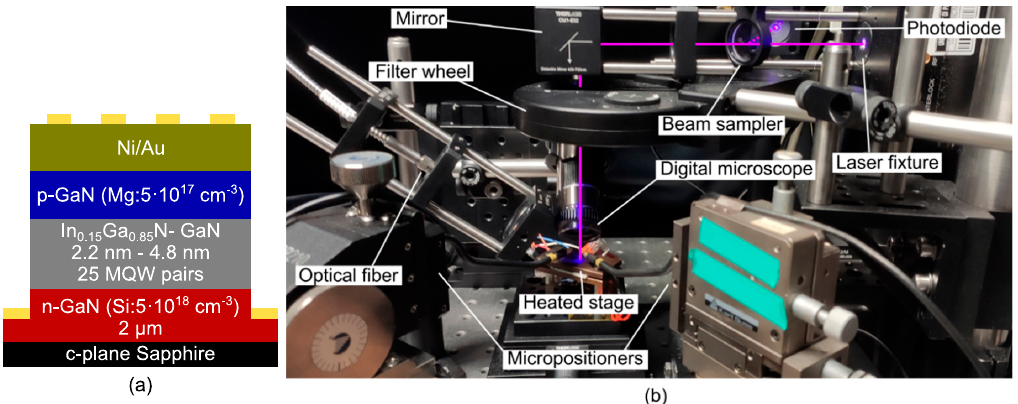
Figure 1. ( a ) Structure schematic of the device under test. ( b ) Photo of the experimental set-up; the laser beam path is highlighted in purple.